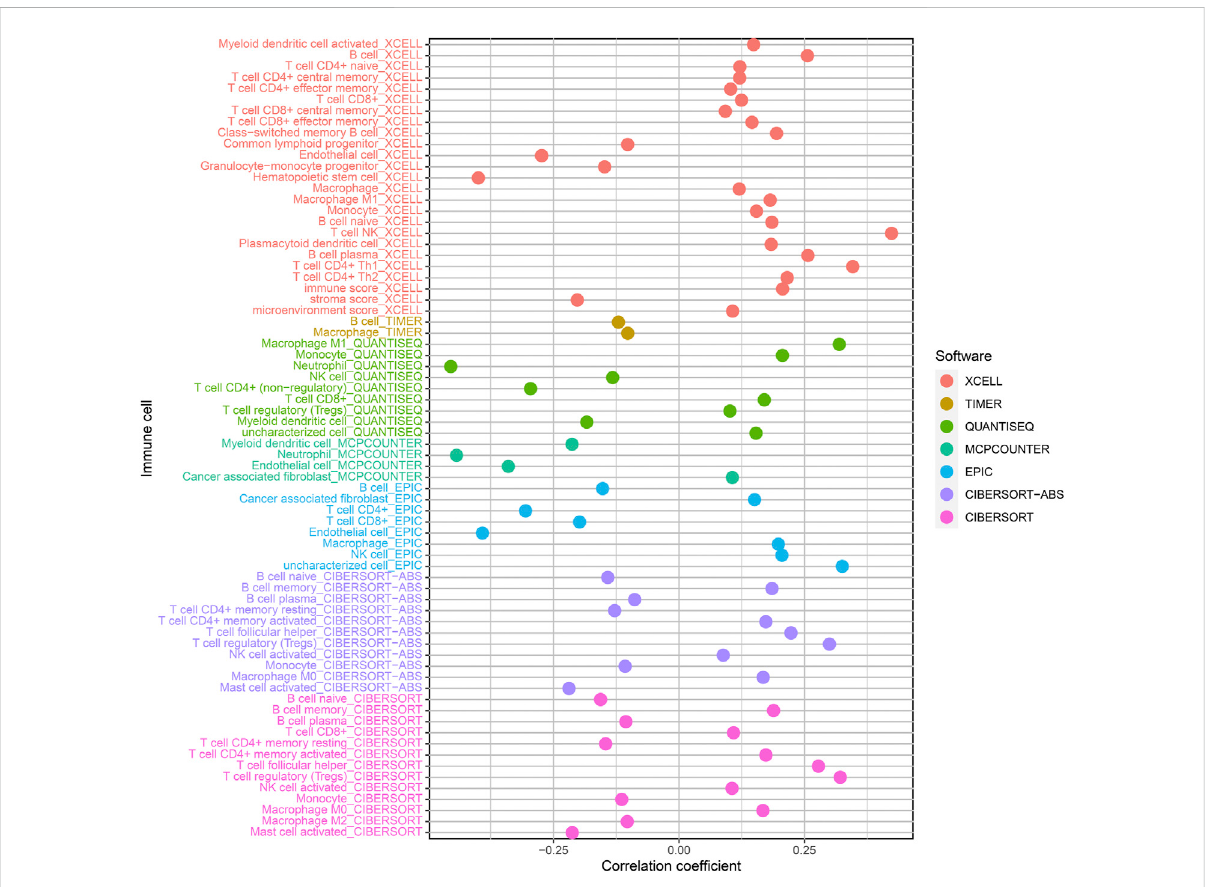
FIGURE 7 Correlation of tumor-in fi ltration immunity cells with the prognostic signature based on 7 known